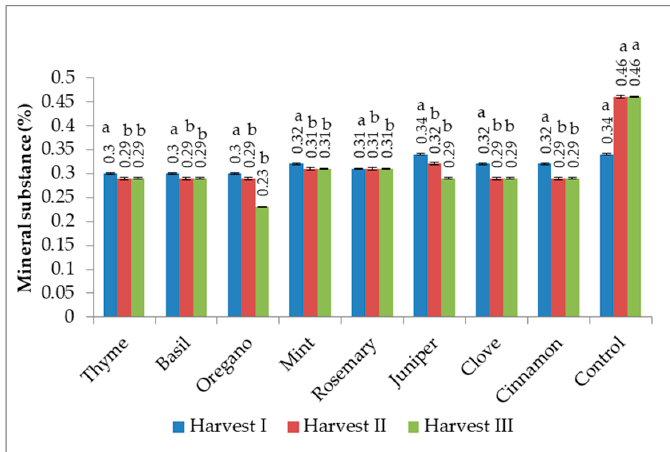
Figure 3. Mineral substances content (%) before (Harvest I), after (Harvest II) the use of EOs in the supplementary feed of bee families, respectively after the first harvest (rapeseed) (Harvest III). Different letters between control and samples indicate significant differences ( p < 0.05) among these values according to the t -test.